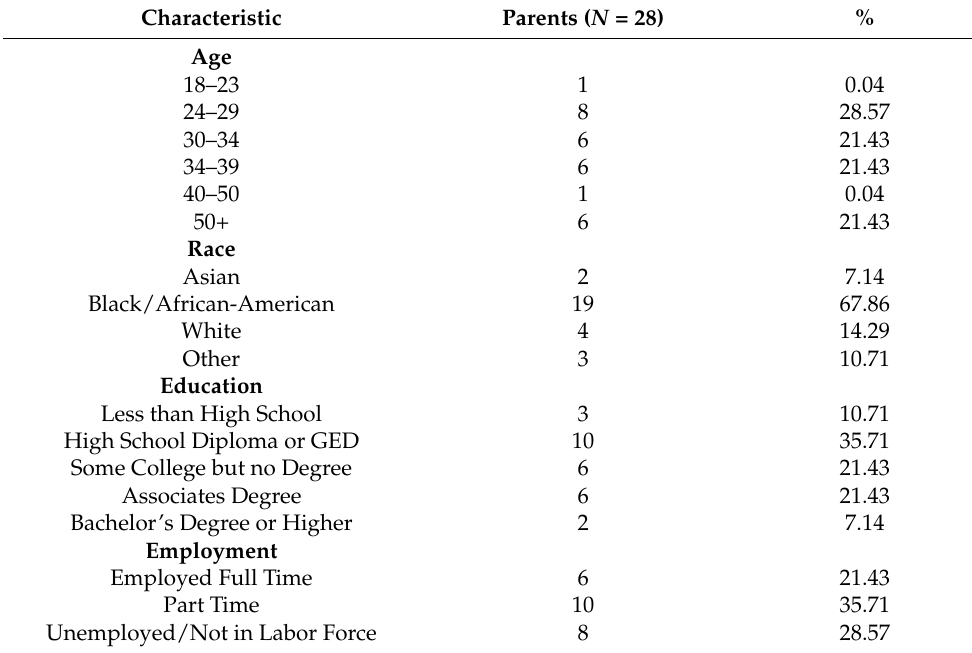
Table 1. Focus group participant